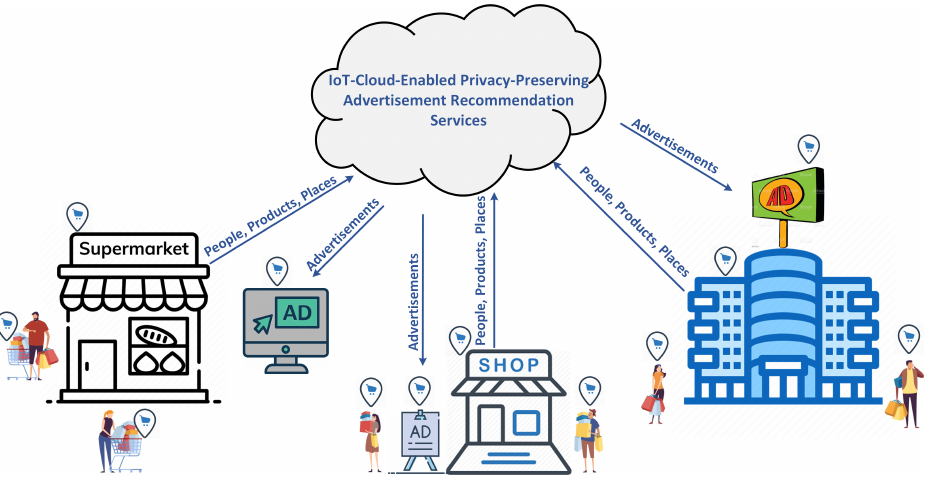
Figure 2. An overview of IoT cloud-enabled privacy-preserving advertisement recommendation